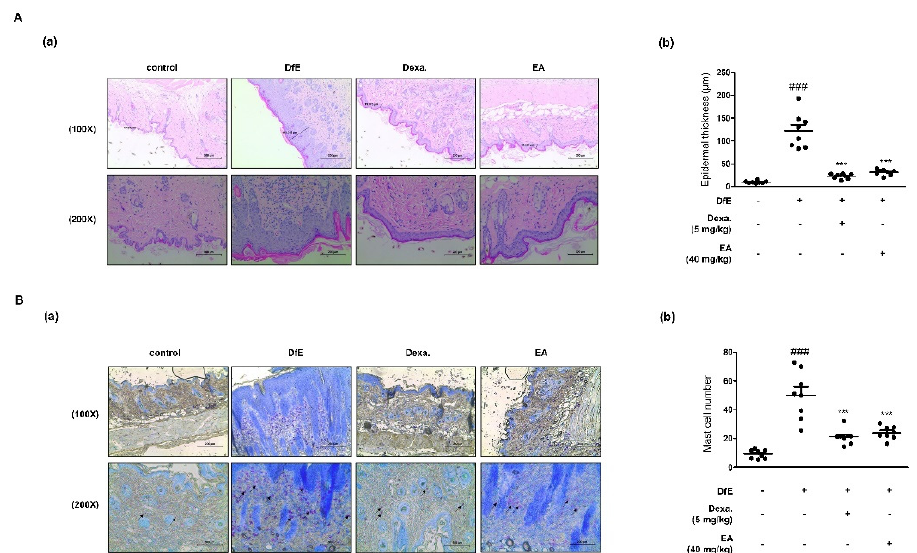
Figure 5. Effects of EA on the histopathological features of DfE-induced AD-like skin lesions in NC/Nga mice ( n = 8). Dorsal skin was excised, fixed in 10% formaldehyde, embedded in paraffin, and sectioned. The tissue sections were assayed by ( A ) hematoxylin and eosin (H&E) staining and ( B ) toluidine blue staining. (( A-a ), ( B-a )) The stained sections were visualized with a microscope at 100 × and 200 × magnifications. ( A-b ) Epidermal thickness was quantified as the mean of five randomly selected areas per mouse. ( B-b ) Mean of the number of infiltrated mast cells was determined from five randomly selected areas per mouse. Data are expressed as the mean ± standard deviation (SD; n = 8). *** p < 0.001 versus the only DfE-treated group, ### p < 0.001 versus the control group by ANOVA and Dunnett’s post-hoc test.